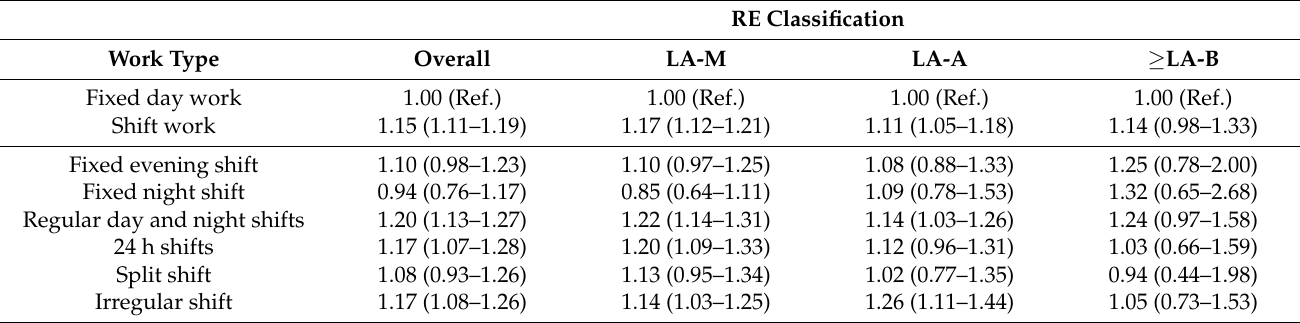
Table 4. Association between shift work schedules and types of reflux